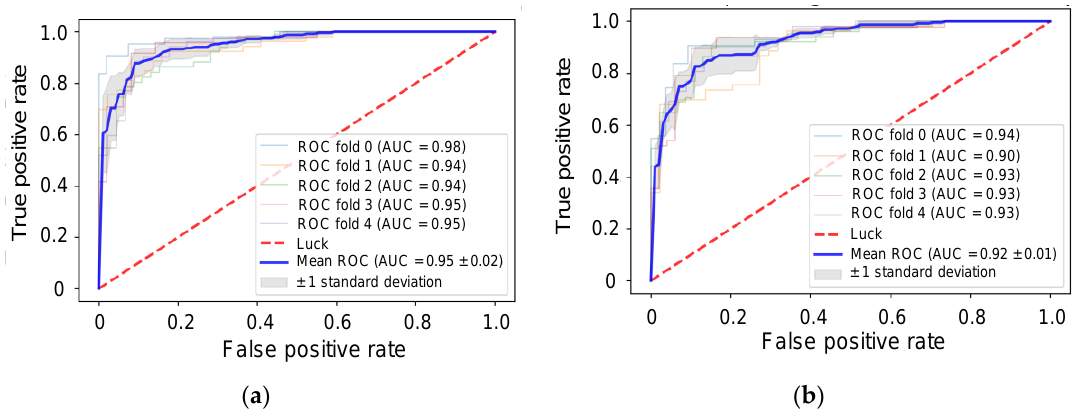
Figure 5. Receiver operating characteristic (ROC) analysis for evaluation of the machine learning models that predict the integration survival subtypes using uncompressed RPPA common datasets. ROC curves of XGBoost ( a ) and LightGBM ( b ).